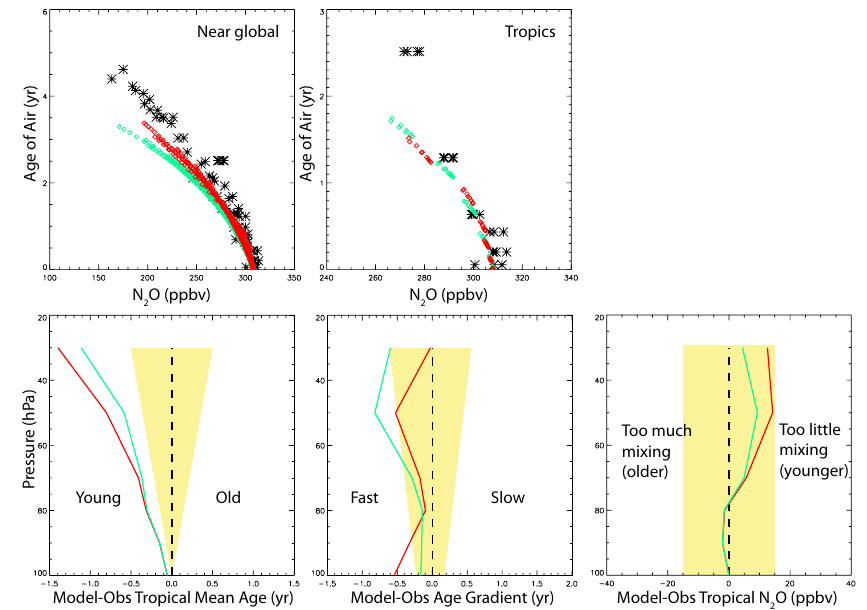
Fig. 7. Diagnostics of stratospheric circulation from the E2-R simulations (green), the E2-MERRA run (red) and observations (black). N 2 O and age of air points are from 150 to 50hPa, 65 ◦ S to 65 ◦ N plus 50–30hPa for 40 ◦ S to 40 ◦ N (upper left) or from 100–30hPa from 10 ◦ S to 10 ◦ N for the tropical analysis (upper right), in both cases with model N 2 O normalized to observations at 100 hPa, 10 ◦ S–10 ◦ N. The age gradient is the difference between the mean ages averaged over 35–50 ◦ N and 10 ◦ S–10 ◦ N. Yellow areas are approximate ± 1 sigma uncertainties from the